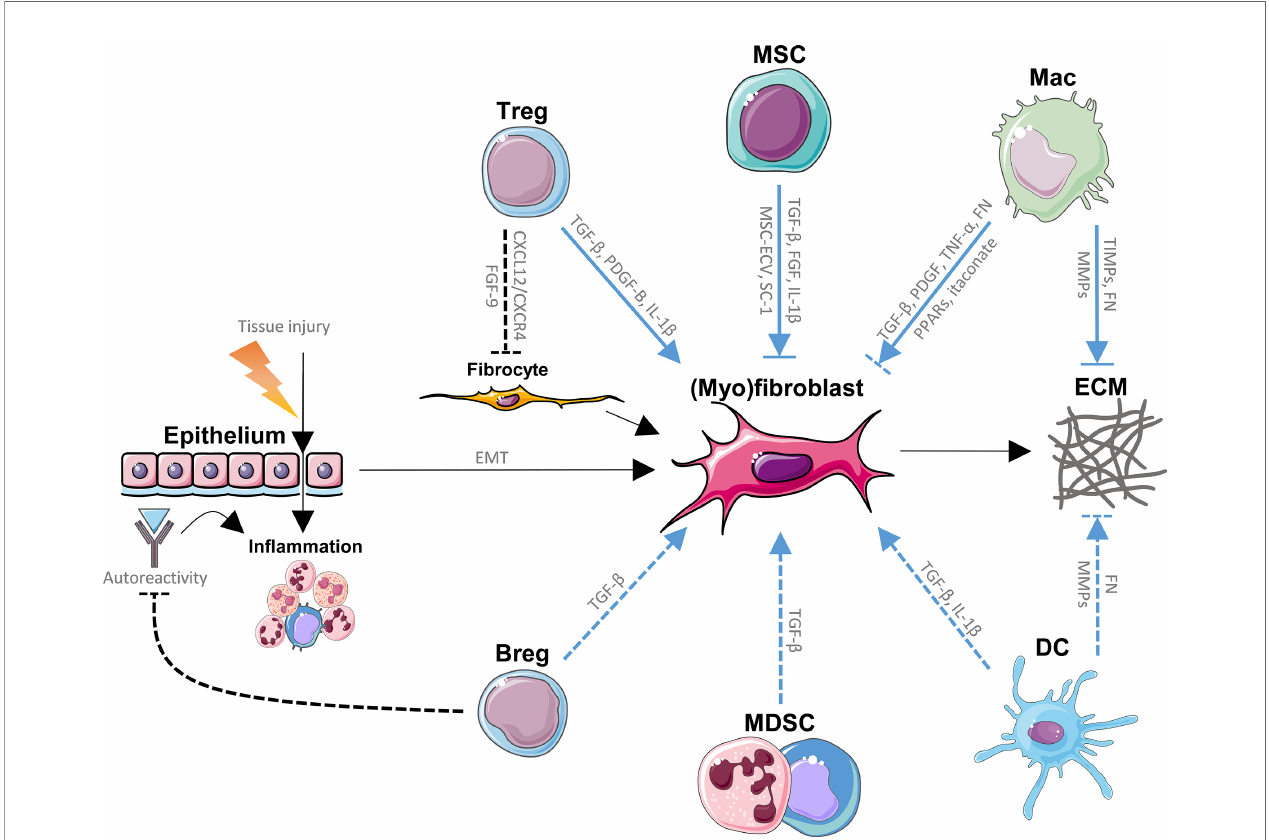
FIGURE 1 | Direct effects of regulatory immune cells on (myo) fi broblasts and extracellular matrix (ECM) in idiopathic pulmonary fi brosis (IPF). Repeated tissue injury triggering chronic tissue damage resulting in in fl ammation, epithelial mesenchymal transition (EMT) and ultimately in excessive production and buildup of ECM by fi brocytes and (myo) fi broblasts ( fi brosis) in the lungs, represents the main paradigm involved in the pathology of IPF. Immune cells with regulatory functions modulate (myo) fi broblast generation, (myo) fi broblast function and ECM homeostasis through various signaling pathways, and known direct pathways are listed here. Mesenchymal stem/stromal cells (MSCs) promote (myo) fi broblasts through fi broblast growth factor (FGF), transforming growth factor (TGF)- b and interleukin (IL)-1 b , while MSC-derived extracellular vesicles (MSC-ECV) and stanniocalcin (SC)-1 have opposite effects. MSCs are also prone to myo fi broblastic transition. Tregs promote fi brogenesis through TGF- b , platelet-derived growth factor (PDGF)-B and IL-1 b , while inhibiting the recruitment of fi brocytes by inhibition of the CXCL12/ CXCR4 axis as well as FGF-9. Macrophages enhance fi brosis through TGF- b , PDGF, tumor necrosis factor (TNF)- a , fi bronectin (FN) and inhibit fi broblasts via itaconate and peroxisome proliferator-activated receptor (PPAR) ligands. Myeloid-derived suppressor cells (MDSCs) and regulatory B cells (Bregs) have been suggested to activate lung fi broblasts, possibly through TGF- b . Bregs inhibit autoreactive immunoglobulins, which may deposit in lung tissue and promote in fl ammation and IPF. Dendritic cells (DCs) have been shown to produce pro- fi brotic TGF- b and IL-1 b . Macrophages (Macs) as well as DCs break down the ECM via matrix metalloproteinases (MMPs), a process that is inhibited by tissue inhibitors of metalloproteinases (TIMPs) produced by other macrophage subtypes. Both Macs and DCs have been found to produce fi bronectin (FN), another ECM component. Blue lines represent the direct effects of regulatory immune cells on (myo) fi broblasts and ECM in IPF. Dashed lines represent interactions that are not fi rmly established in IPF. This fi gure was created using Servier Medical Art templates, which